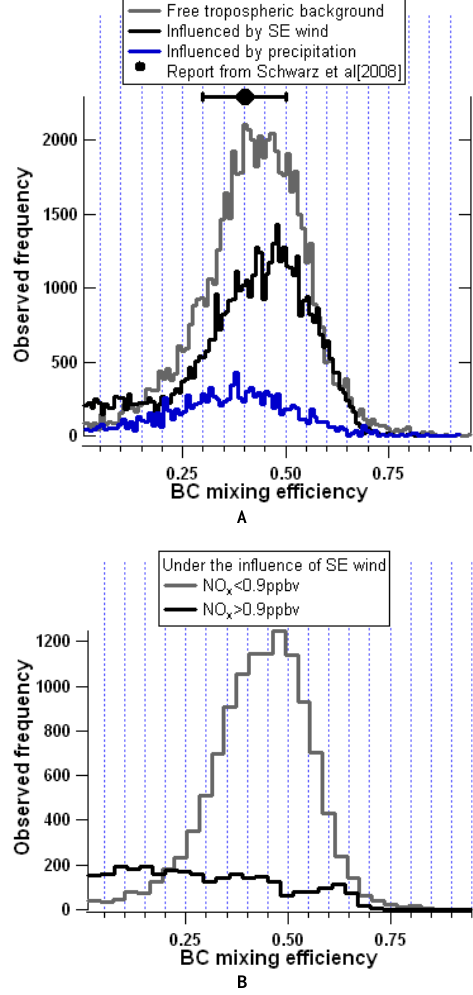
Fig. 9. Fig. 9. (A) The frequency distribution of BC mixing efficiency un- der different conditions as categorized in Fig. 7. The range of values reported by Schwarz et al. (2008a) from the northern tropic tropo- sphere is indicated. (B) The BC mixing efficiency under the influ- ence of SE wind, as categorized by different levels of NO x concen-